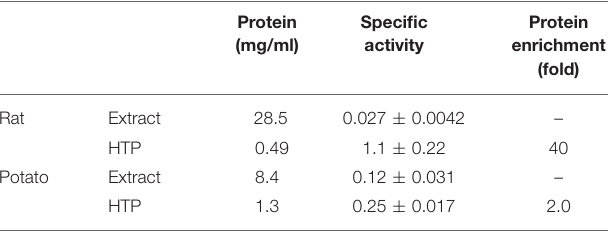
TABLE 1 | Partial protein enrichment of the mitochondrial ascorbic acid transporter from rat liver and potato.